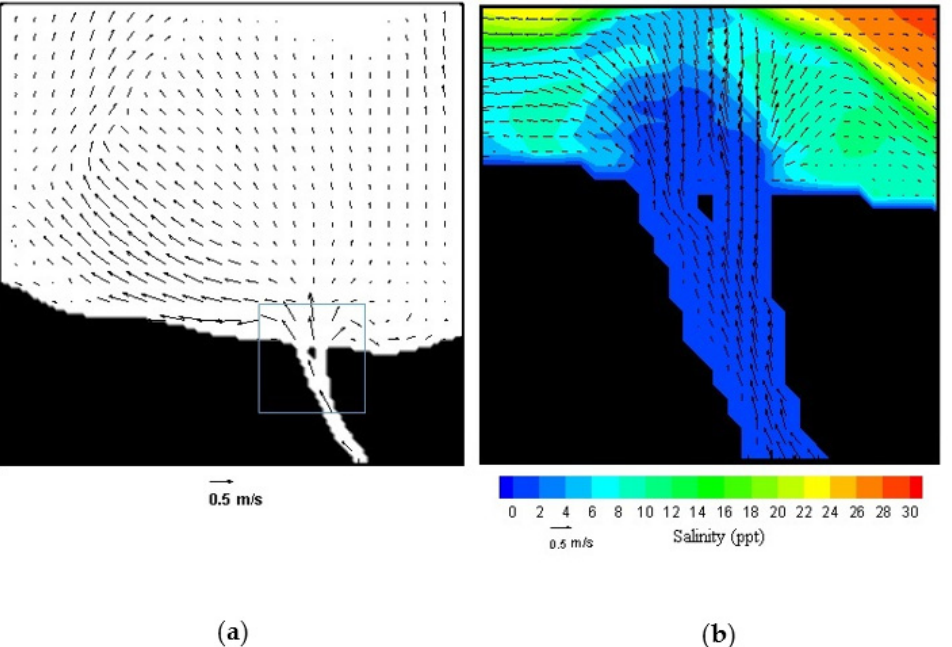
Figure 5. Current pattern at high slack wáter condition ( a ) model II and ( b ) model III. The location of the delta in the middle of the river mouth causes the current to spread west and east after the current passes through the delta. The simulation results (Figure 6) show that the currents generated by the tides and the discharge move at a higher velocity to the west, then weaken towards the north due to changes in depth. The current velocity is greater in the deeper area compared to the surrounding area. Depth degradation causes the flow to form eddies by slowing current velocity due to friction at the bottom of the water and increasing current velocity by silting waters [41,42].